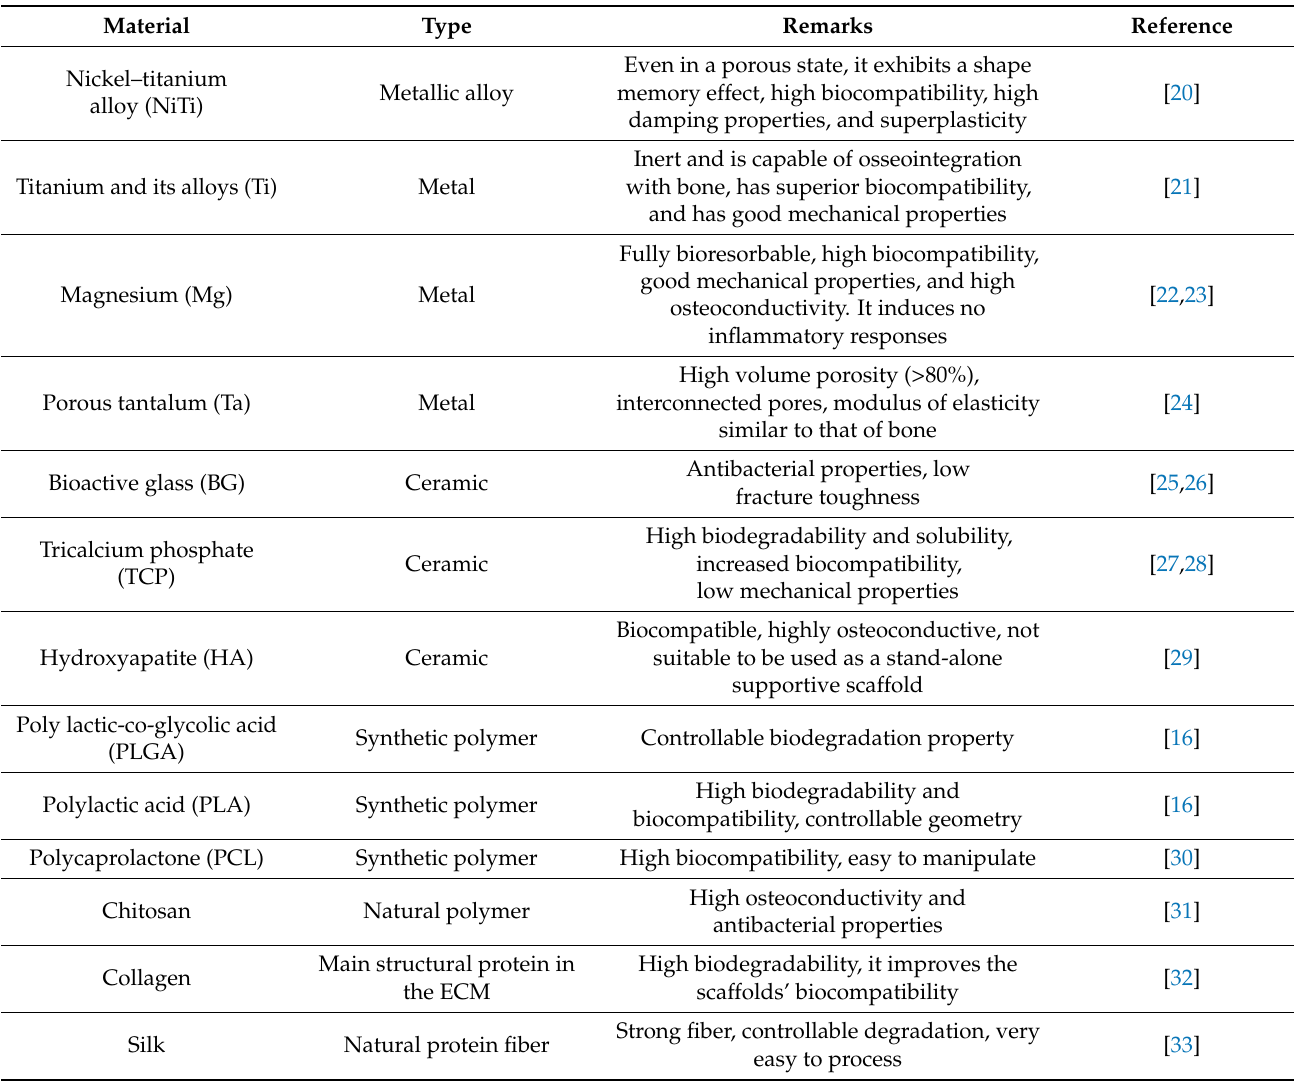
Table 1. Materials used in bone tissue engineering